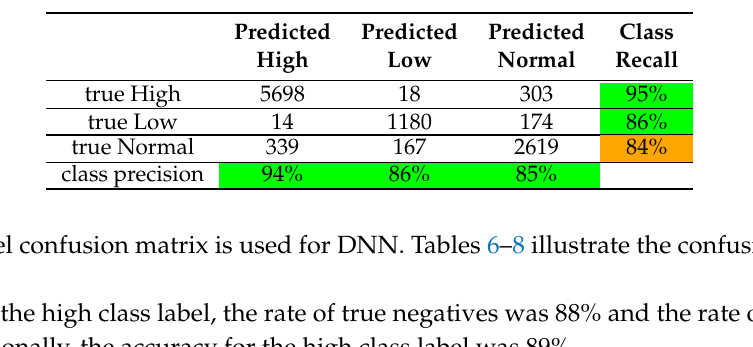
Table 5. Confusion matrix for RF.